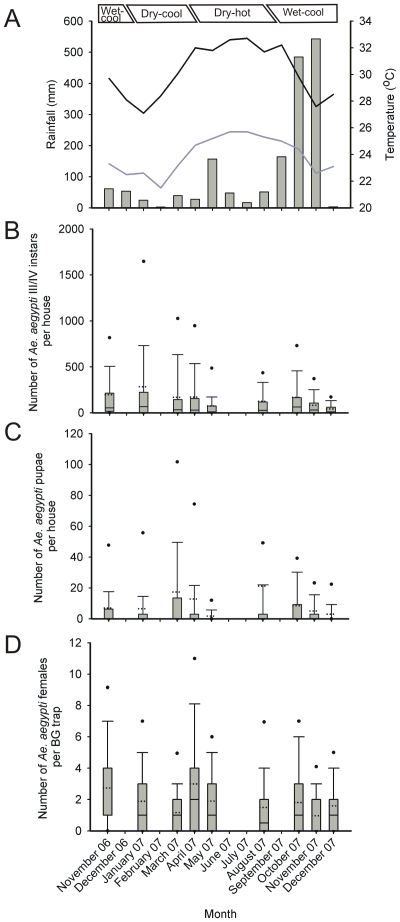
Temporal abundance of Aedes aegypti in Tri Nguyen village during different seasons.A) Mean monthly minimum and maximum temperatures (°C), and total monthly rainfall (mm), recorded during the survey period from Nha Trang weather station. B–D). Box plots of the number of Ae. aegypti III/IV instars and pupae per house, and female Ae. aegypti per BG-trap, for each of the surveys in Tri Nguyen village. Central line = median, dotted line = mean, box = 25th/75th percentiles, whiskers = 10th/90th percentiles, dots = 5th/95th percentiles. Boxed text shows the different seasons in central Vietnam based on 5 year historical weather data.